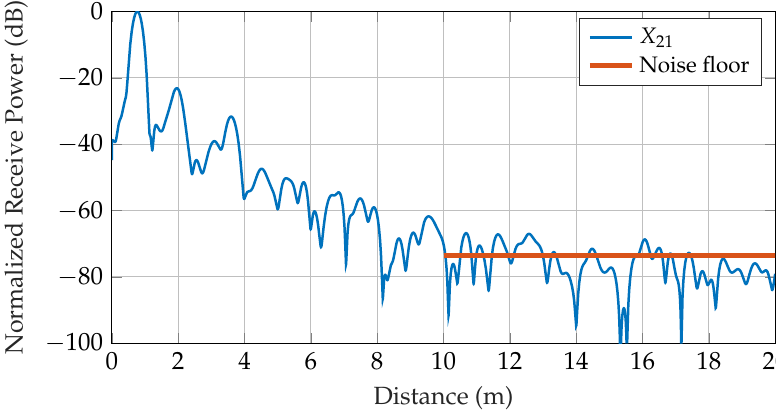
Figure 10. Normalized range spectrum of forward path TOF measurement averaged over 90 consecutive runs with air-filled gas container. Noise floor is estimated using power level present in range 10–20 m, where influences of the setup’s surroundings and multi-path reflections are